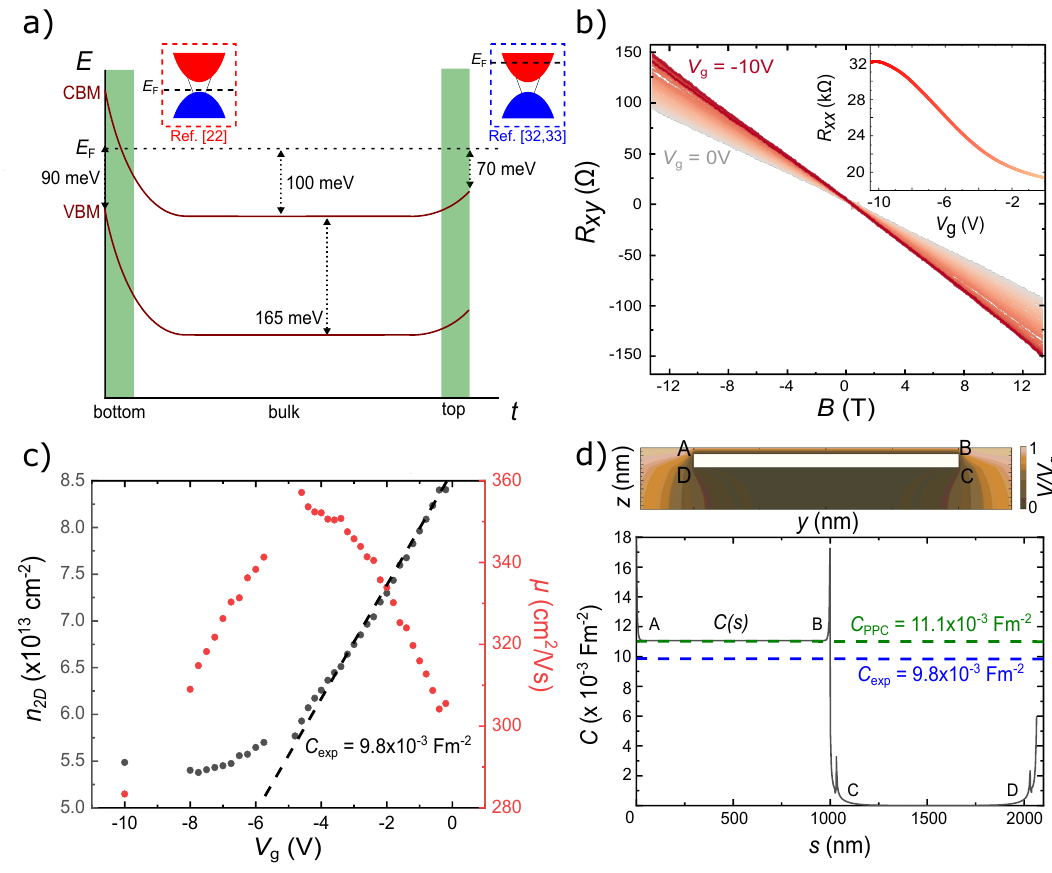
Figure 2: Gate-dependent Hall- and longitudinal resistance of the 1 µ m wide Hall bar. a) Expected relative position of the Fermi energy within the bulk as well as on top and bottom surface of the ribbon device. b) Hall resistance R measurements x y / dB have been used to at different gate voltages V . The extracted Hall slopes dR x y g evaluate the sheet carrier concentration n shown in c) (black dots). The mobility 2D µ values (red dots) have been evaluated by considering the gate-dependent sheet ( V ) at resistance R , extracted from the gate-dependent longitudinal resistance R S xx g zero magnetic field shown in the inset of b). In d) the simulated relative gate poten- tial V / V (top) and calculated position dependent capacitance C ( s ) (bottom) along g the microribbon perimeter P are displayed. The dashed blue line represents the ex- perimentally determined capacitance from c), while the dashed green line represents the estimated capacitance on the top surface considering a parallel plate capacitor